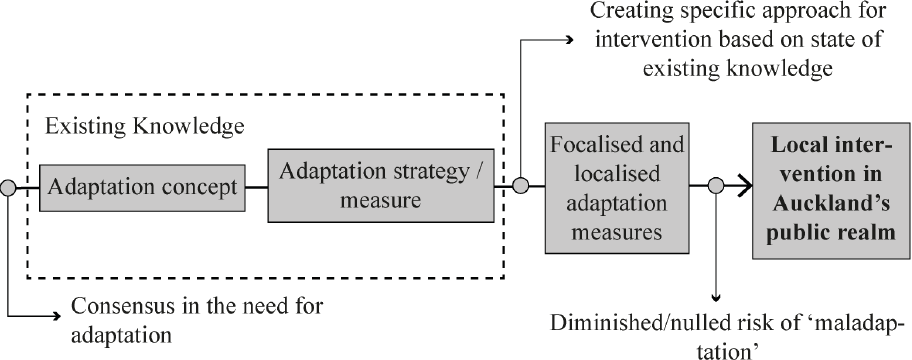
Figure 5. Proposing adaptation measures which focus upon Auckland’s public realm and local risk factors. Adapted with permission from Taylor & Francis